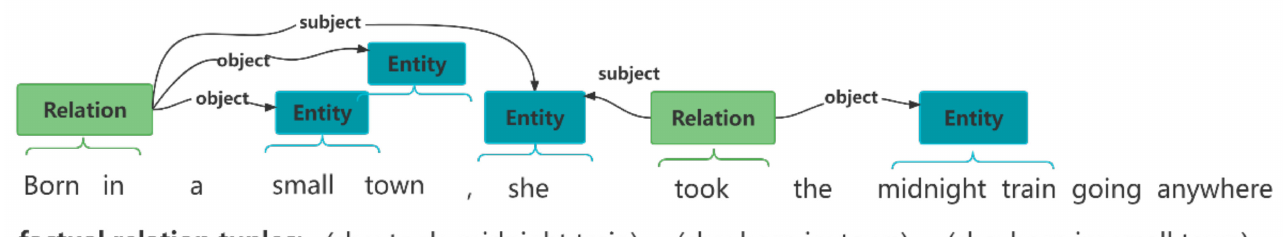
Figure 1. Factual relation tuples extracted from a